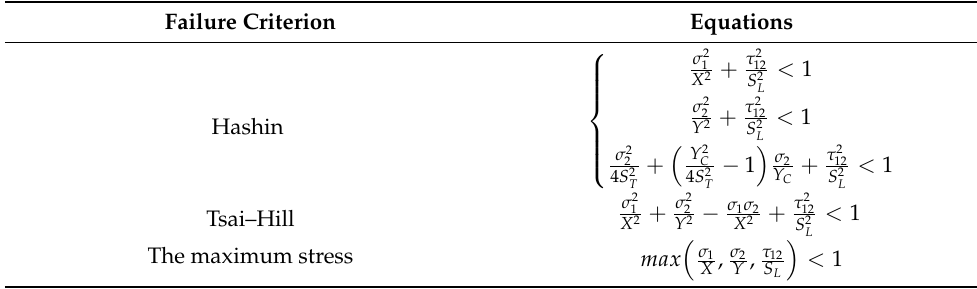
Table 5. The failure criteria used in the FDM